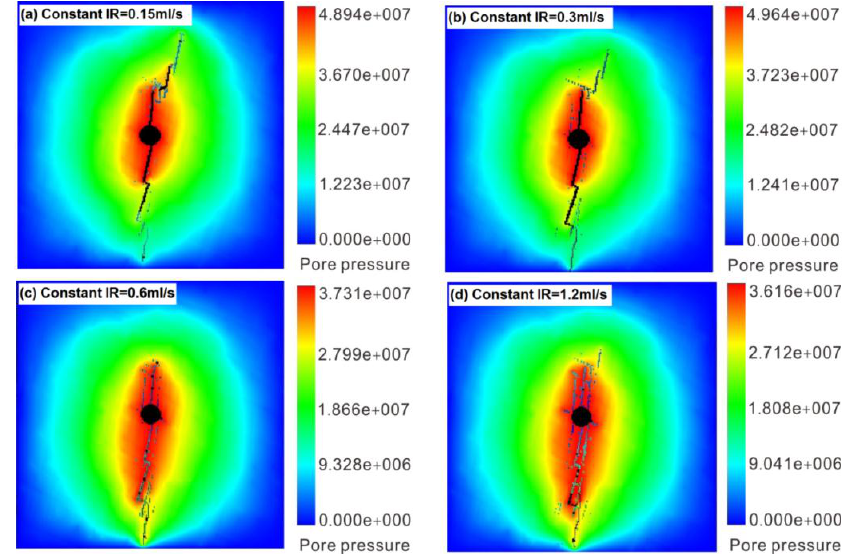
Figure 10. General observations of the hydraulic fracturing process for constant injection rate cases (Color shadow indicate relative magnitude of the pore water pressure field) at the constant injection rate: ( a ) 0.15 mL/s; ( b ) 0.3 mL/s; ( c ) 0.6 mL/s; and ( d ) 1.2